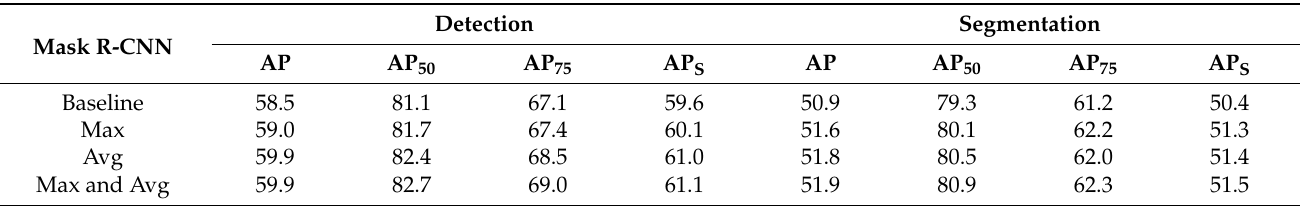
Table 6. The effect of pooling functions on model